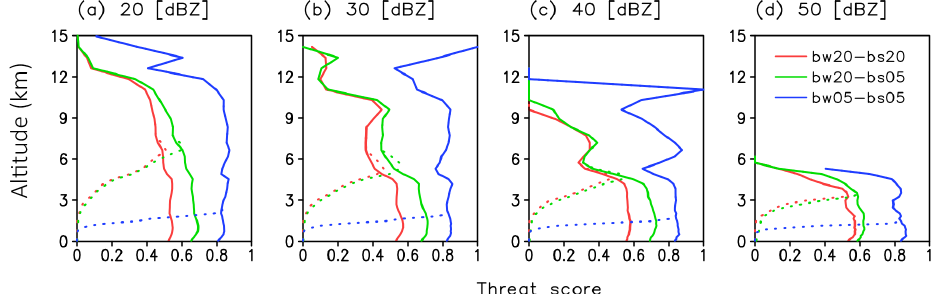
Figure 10. Threat score with a threshold of (a) 20, (b) 30, (c) 40, and (d) 50 (dBZ) for bw20bs20 (red), bw20bs05 (green), and bw05bs05 (blue). The dotted and solid lines show the threat score with and without considering the impact of surface clutter, respectively.